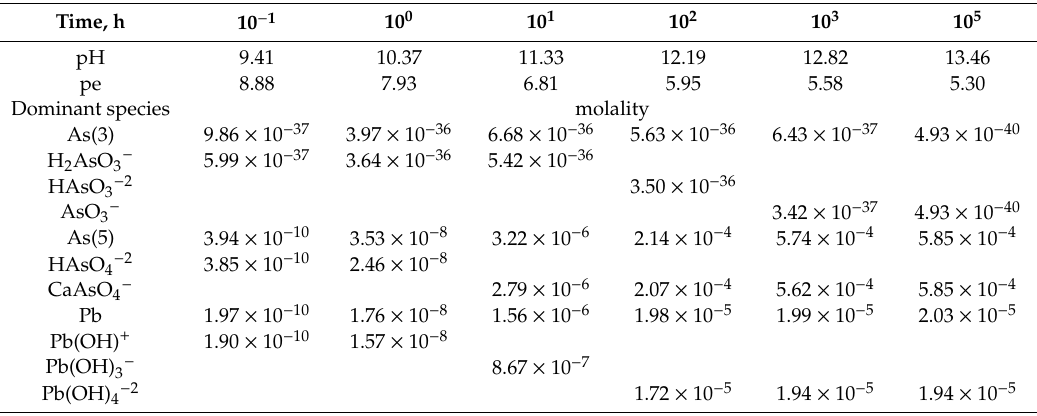
Table 9. Composition of solution and distribution of species vs. the leaching stages (modeling results).